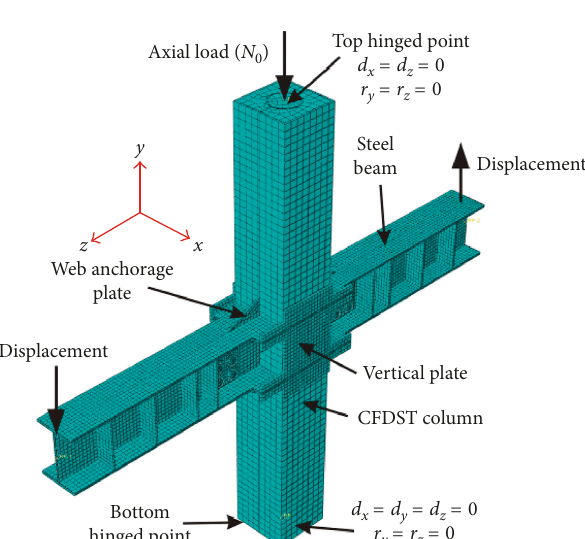
Figure 6: General view of the FEA model of the SBJ2-2 specimen.